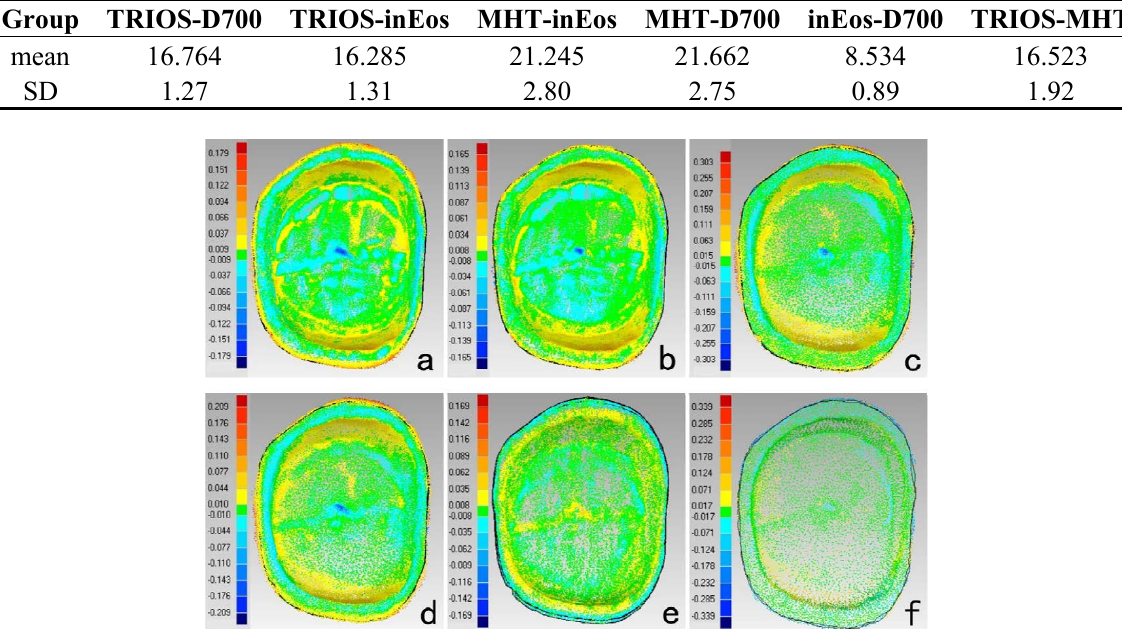
Table 3. Statistical analyses of RMS between groups ( μ m).